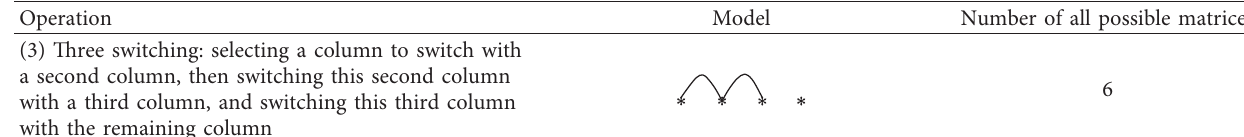
Table 4: Three switching